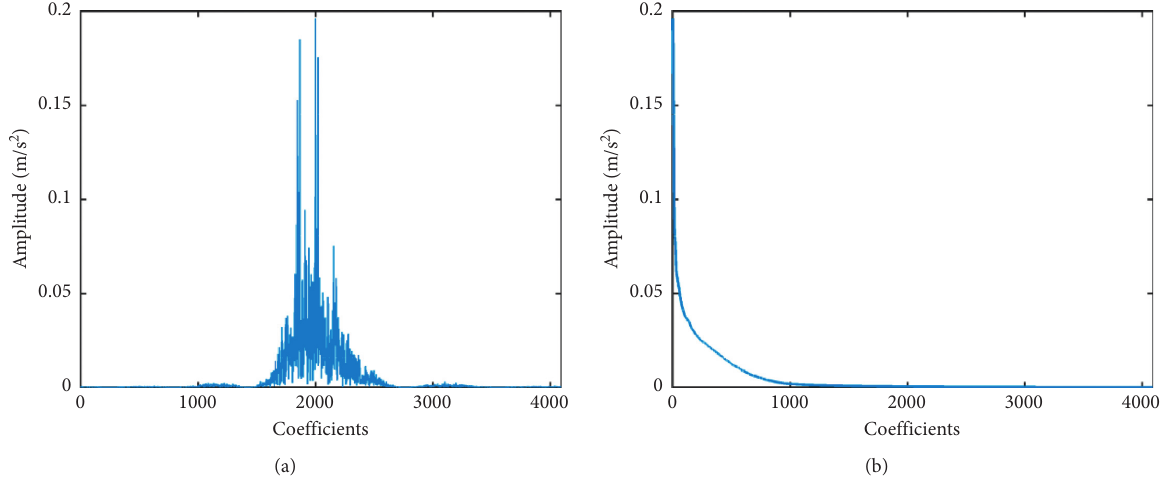
Figure 10: In Fourier dictionary, (a) sparse coefficients of the mode 3 and (b) attenuation curve of (a).